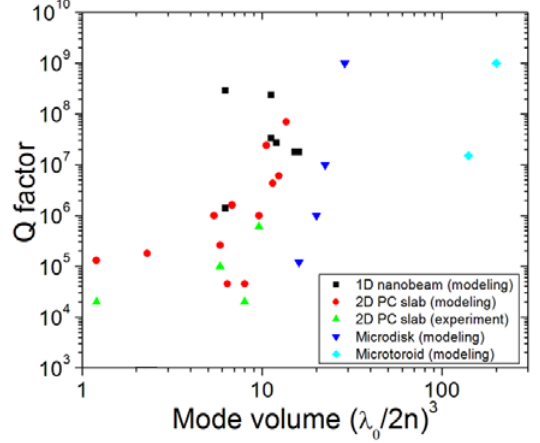
Figure 4. Q factor versus mode volume: The data are collected from some papers on 1D nanobeam, 2D photonic crystal slab, microdisk, and micro-toroid optical resonators